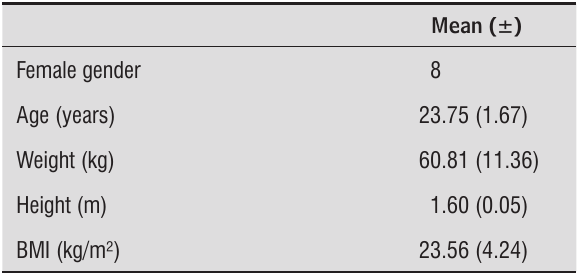
Table 1 - Characteristics of volunteers (n = 8)